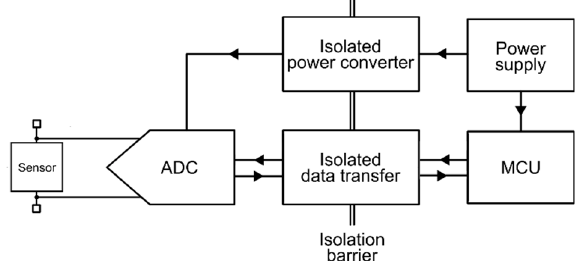
Figure 2. Simplified scheme of an isolated ADC for a sensor interface.